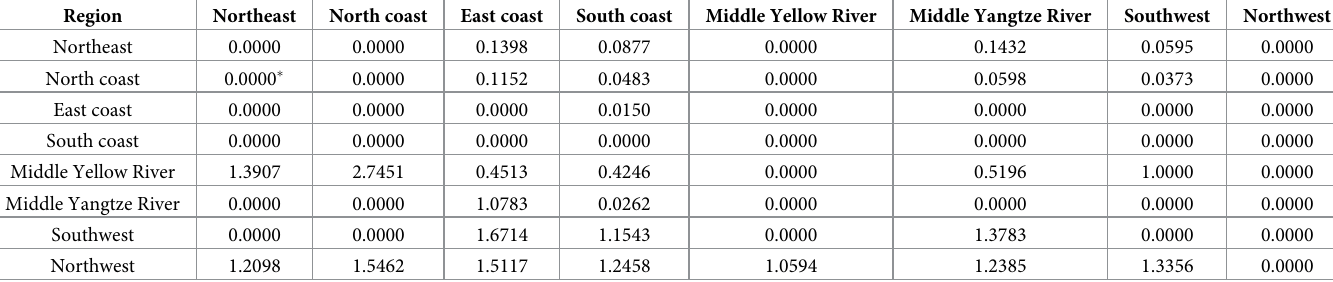
Table 6. The matching degree of embodied carbon trade and value-added trade among the eight regions in 2012. Region Northeast North coast East coast South coast Middle Yellow River Middle Yangtze River Southwest Northwest Northeast East